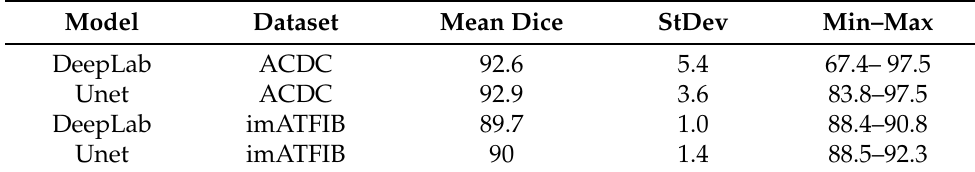
Table 1. Perfect ROI results on the ACDC and imATFIB validation sets. The imATFIB dataset “mean” refers to the average Dice of all volumes (whole-heart vs background), whereas the ACDC dataset “mean” refers to averaging the dices on the three segmented heart substructures as well (StDev—Standard deviation, Min–Max—range determined by the minimum, respective maximum dice values obtained on the